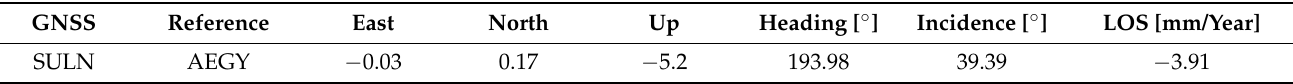
Table 1. Projection of 3D SULN GNSS measurements to Sentinel-1 LOS direction